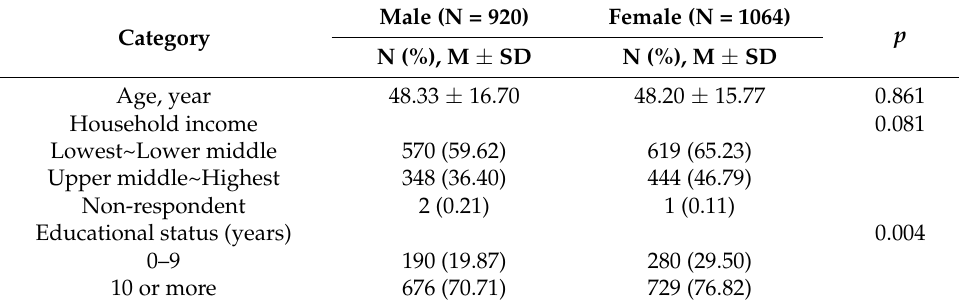
Table 1. Baseline characteristics of participants (N =